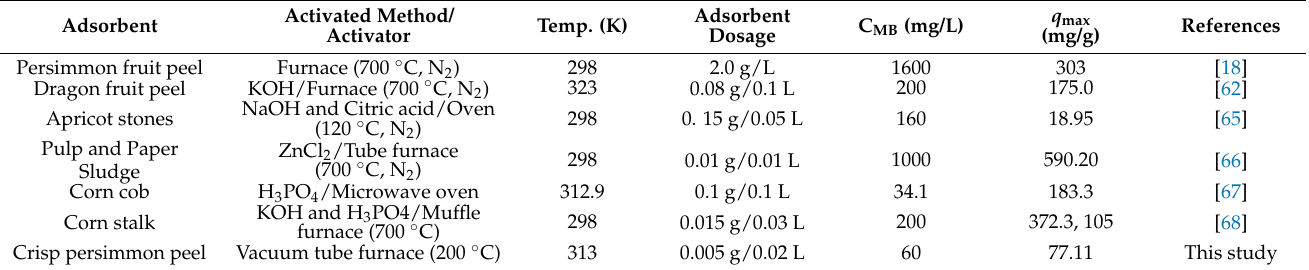
Table 2. A comparison of adsorption capacities of CPP200 for MB with other previously reported carbon-based adsorbents under optimal experimental